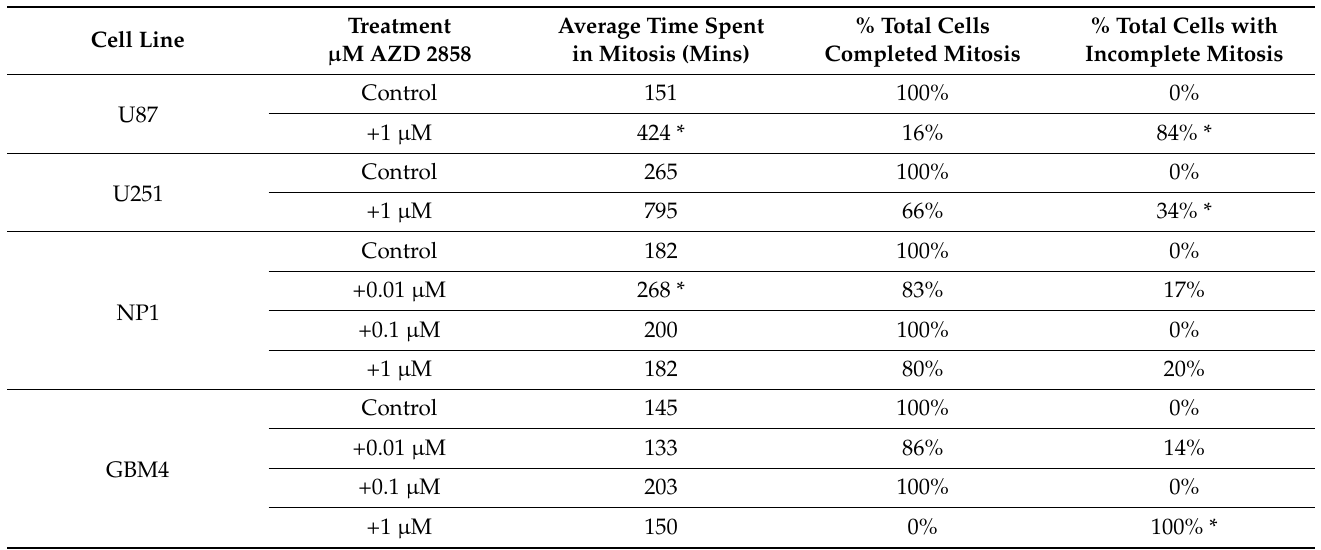
Table 1. AZD2858 induces cytokinetic failure and mitotic arrest in glioma cells. Treatment with AZD2858 causes prolonged mitosis, a decrease in the number of completed mitoses, and increase in cell death during mitosis. * Indicates statistically significant differences between untreated and treated